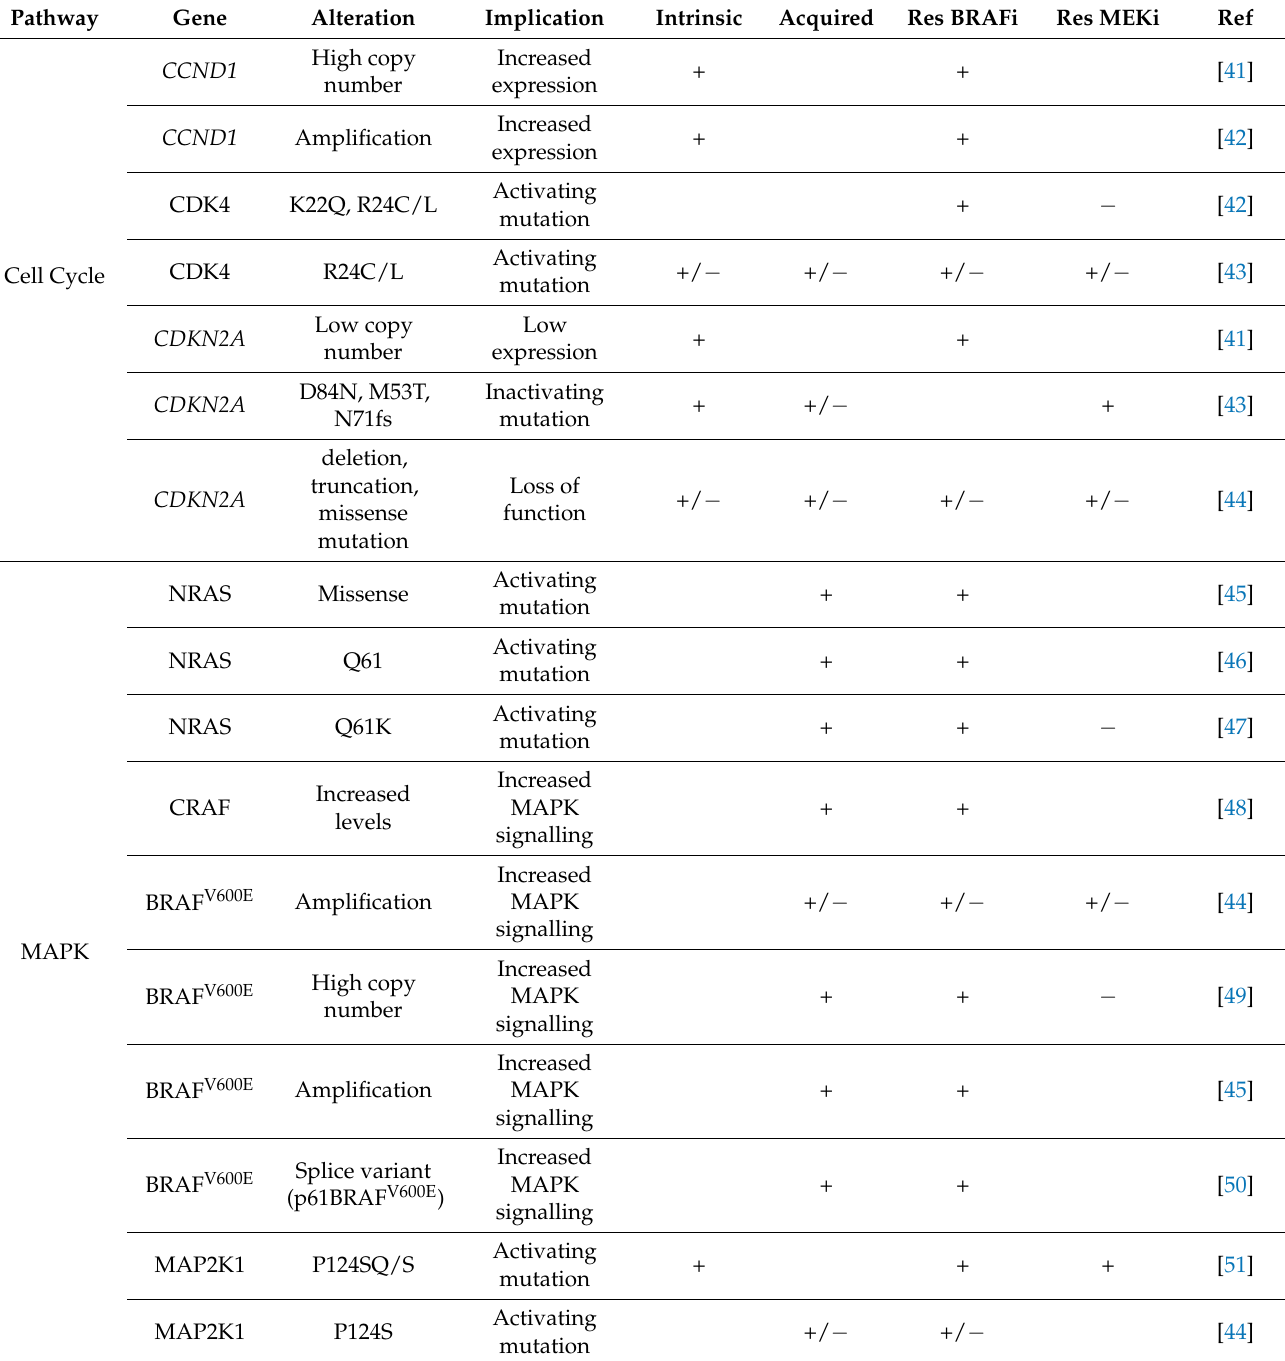
Table 1. Representative list of mutations contributing to resistance mechanisms to targeted therapy in melanoma. + → resistance; +/ − → partial resistance; − → response. Pathway